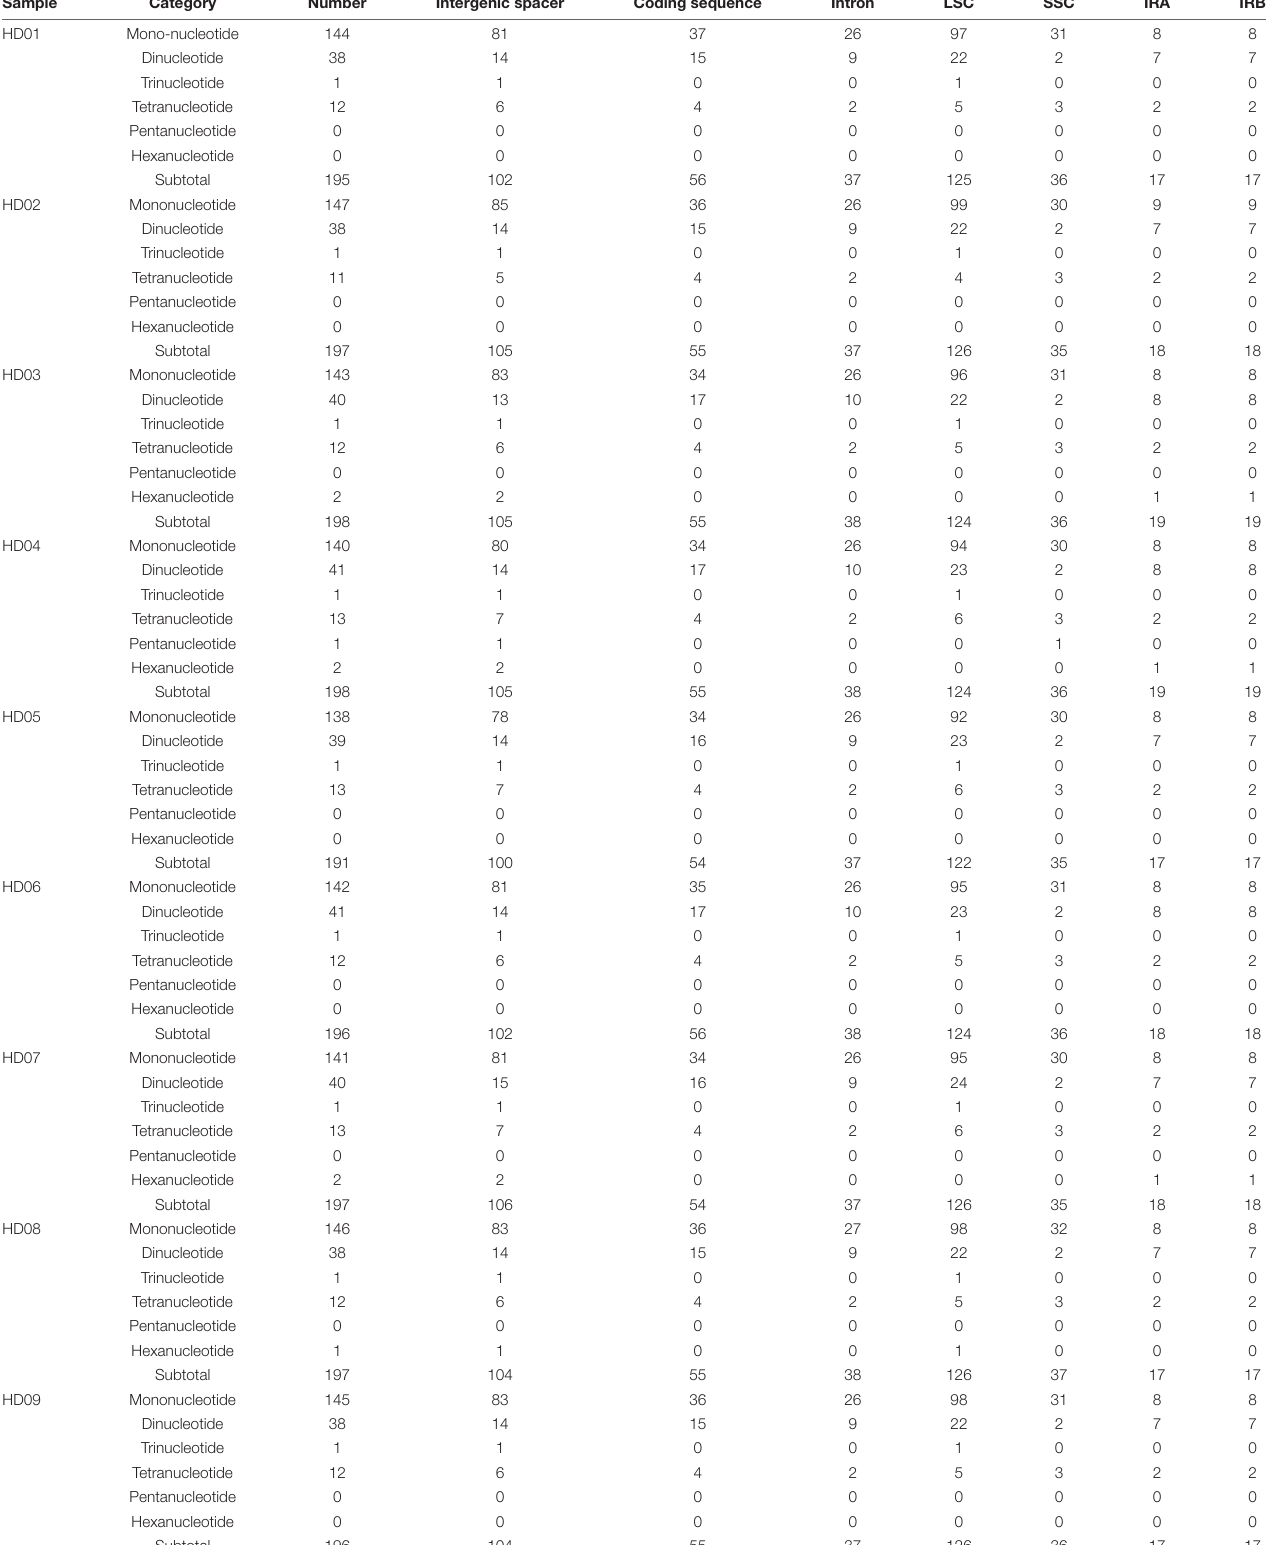
TABLE 6 | Simple sequence repeats (SSRs) in chloroplast genome (cpDNA). Sample Category